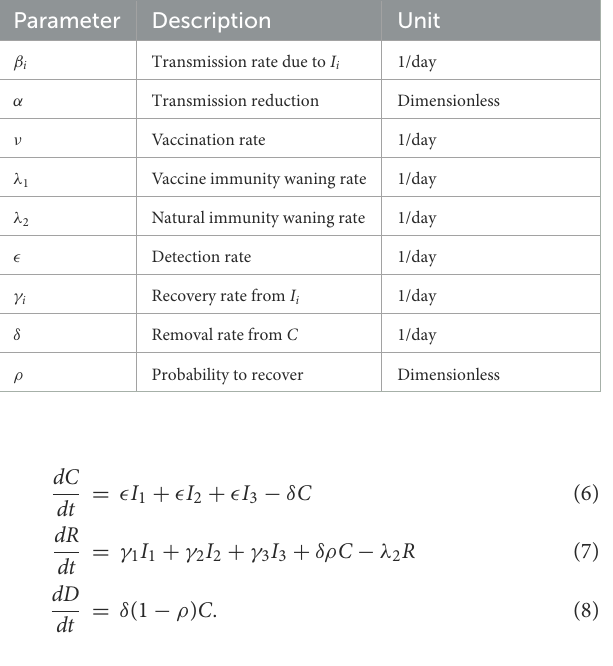
TABLE 1 Parameters of the